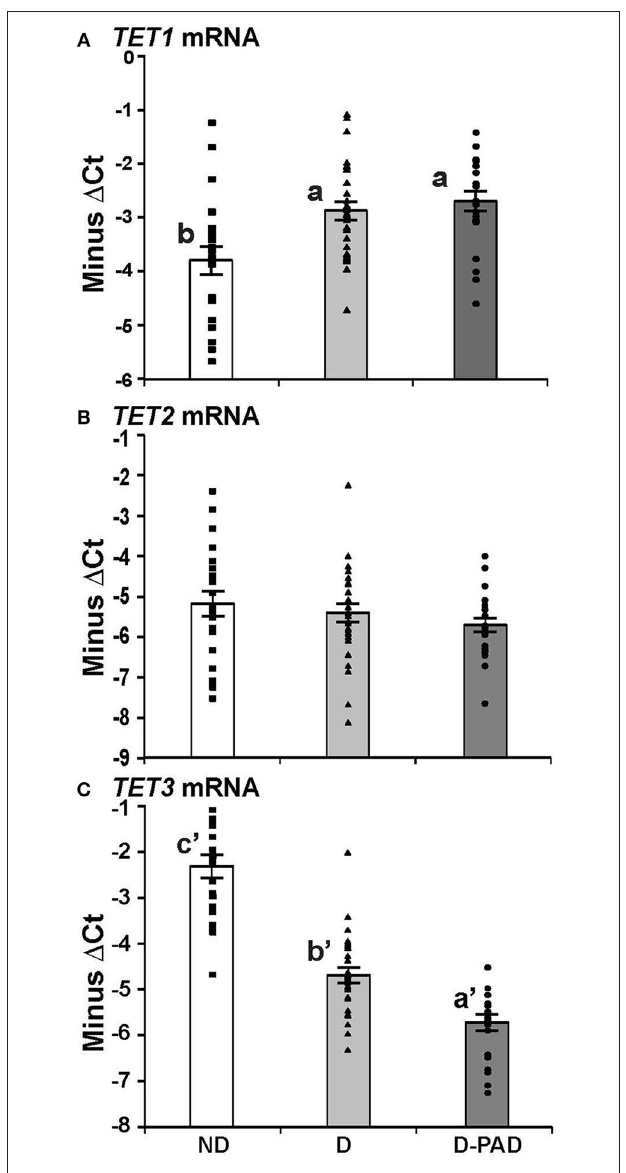
FIGURE 2 | Comparison of the relative expression levels of TET1 (A) , TET2 (B), and TET3 (C) mRNA in EPCs of subjects in ND, D and D-PAD groups. EPCs were isolated from subjects in ND ( n = 22), D ( n = 28), and D-PAD ( n = 22) groups and cultured as described in the Material and Methods section. Total RNA of EPCs was isolated and subjected to real-time PCR analysis. The results were presented as mean ± SEM of the – 1 CT (the CT of β -actin—the CT of indicated transcript). The distribution ranges of the – 1 CT values of their genes were shown with the columns in the graph. The data were analyzed with one way ANOVA (a > b, P < 0.0012 for comparing ND and D-PAD groups, and P < 0.0034 for comparing ND and D groups; and a ′ < b ′ < c ′ , P < 7.1E-11 for comparing ND and D groups, and P < 7.2E-05 for comparing D and D-PAD groups). ND, non-diabetic; D, Diabetes only; D-PAD, diabetes peripheral artery disease.